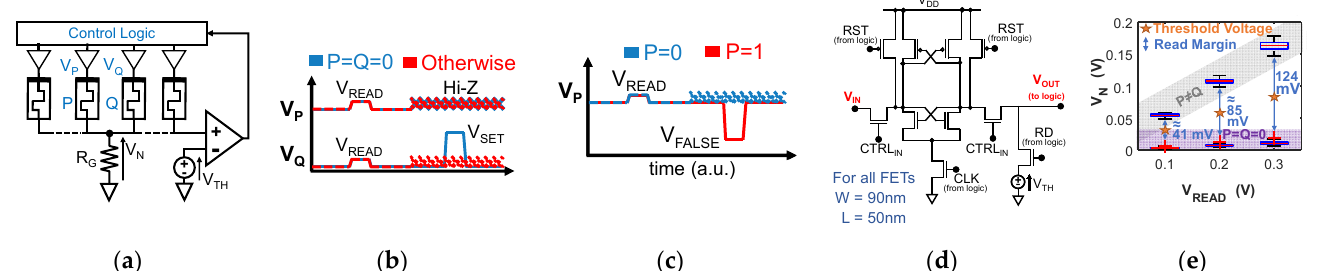
Figure 4. ( a ) Schematic of the SIMPLY architecture implemented on a linear RRAM array. ( b ) Pulses applied to the top electrodes of P (V P ) and Q (V Q ) to execute the IMPLY operation in SIMPLY architecture when the comparator detects P = Q = 0 (blue lines) and in all other cases (dashed red lines). ( c ) Pulse applied at the top electrode of P to perform the sFALSE P operation in SIMPLY architecture when P = 0 (dashed blue lines) and P = 1 (red lines). ( d ) Comparator implementation from [30] that is used in this work (45 nm technology [34]—MOSFETs W/L are shown). ( e ) Distribution of V N (technology 3 [29]) resulting from circuit simulations including variability and RTN (50 trials) when P = Q = 0 (violet bands) and P ≠ Q (grey bands) for a the 2-SIMPLY operation at different V READ . The read margins (RM—blue arrows) and associated threshold voltages (V TH —orange stars) for the comparator are evidenced. Black whiskers indicate the extreme points of the distributions. Red crosses indicate outliers due to RTN. V N when P = Q = 1 is always much higher than in all other cases (thus is not reported in these box